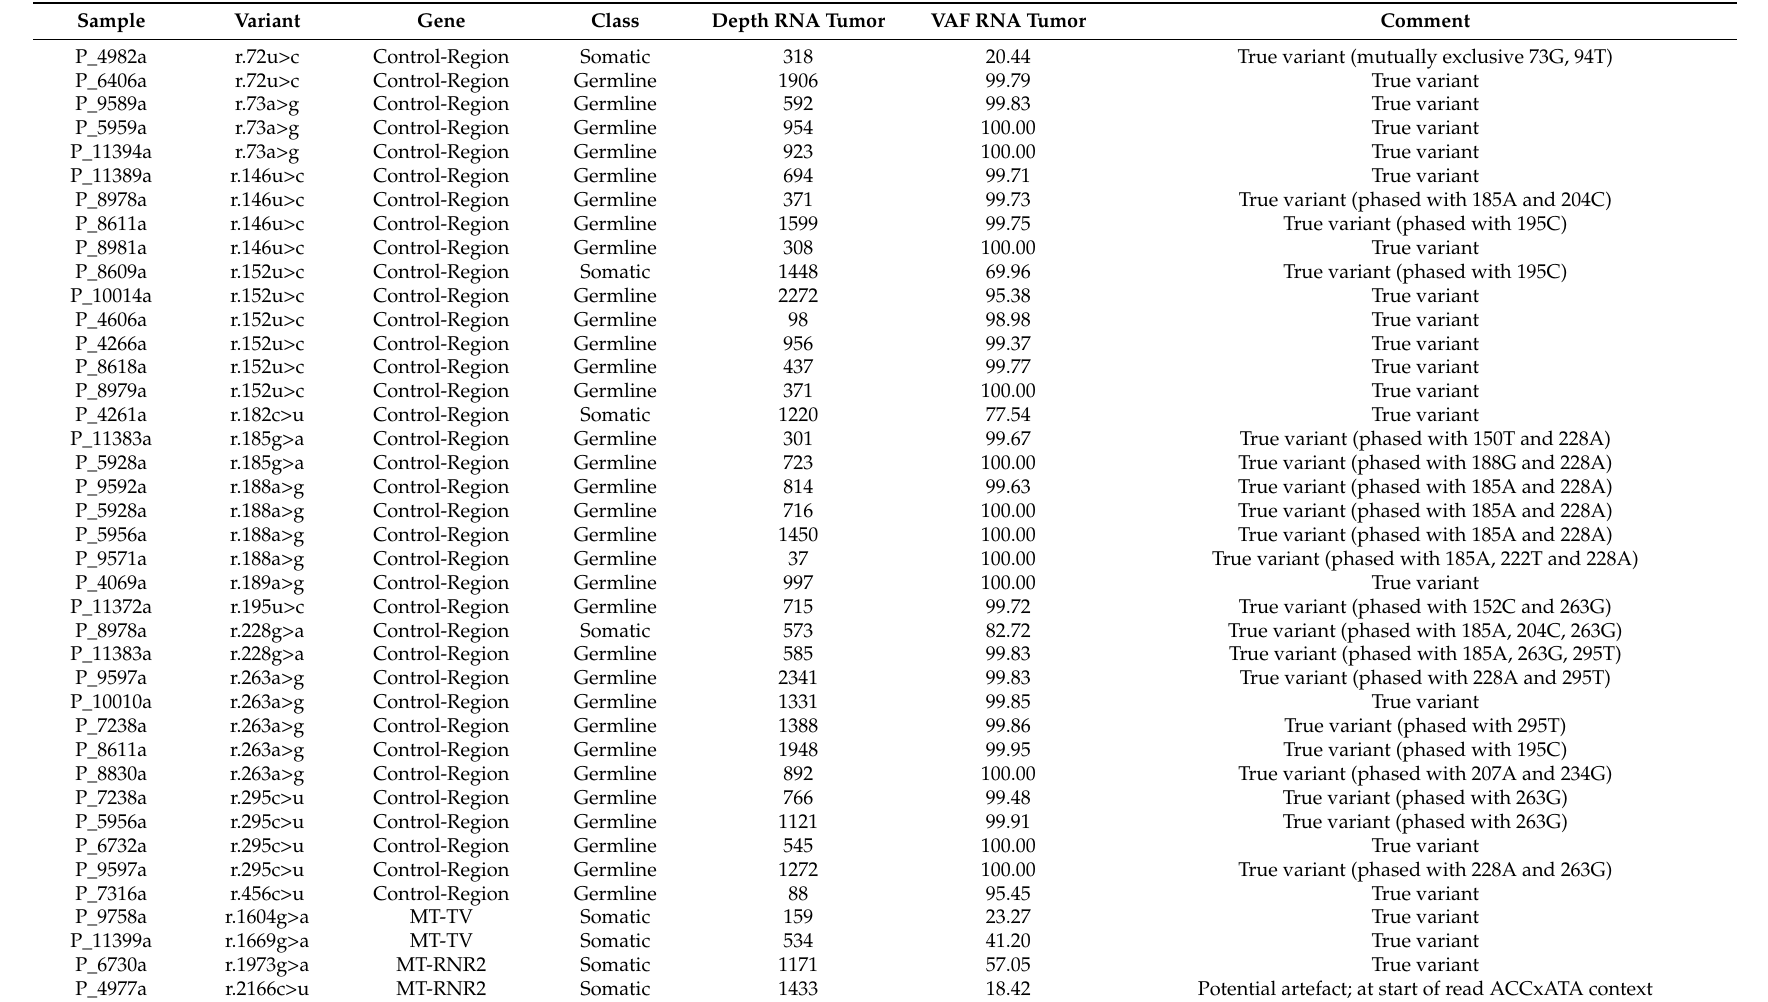
Table A3. Variants at only the mtRNA